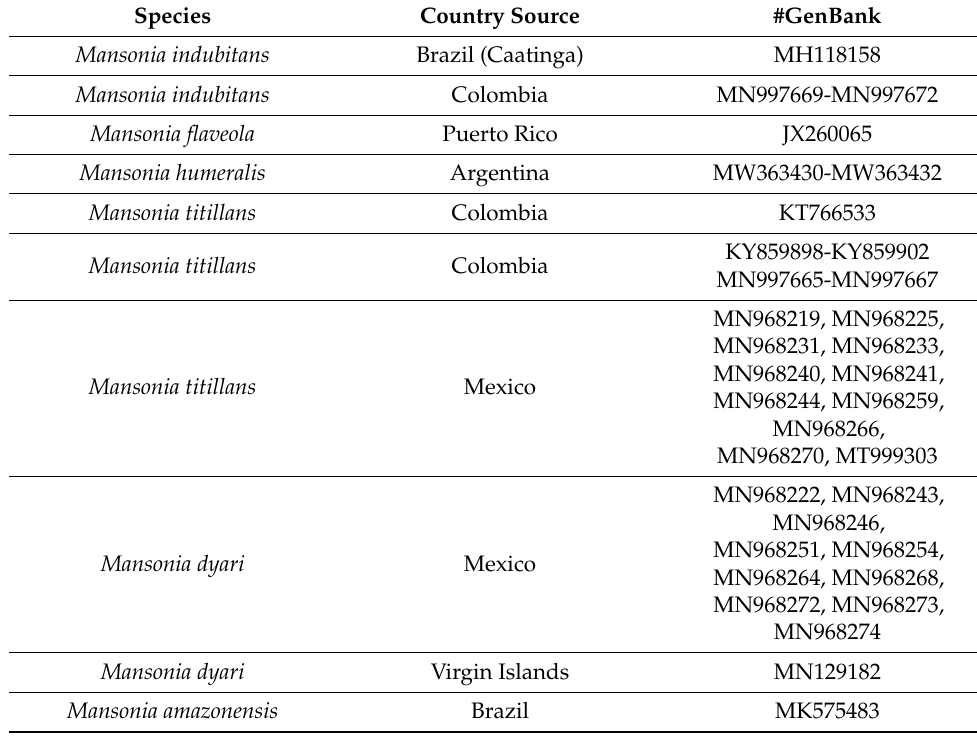
Table 2. GenBank accession numbers of the reference Mansonia (Man.) sequences used in the